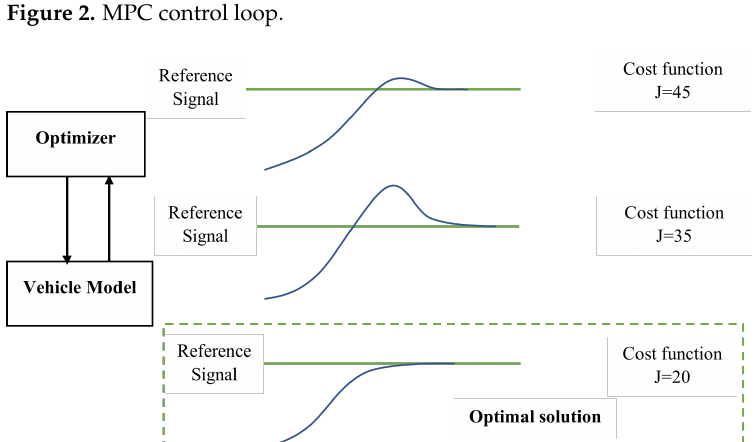
Figure 2. MPC control loop.